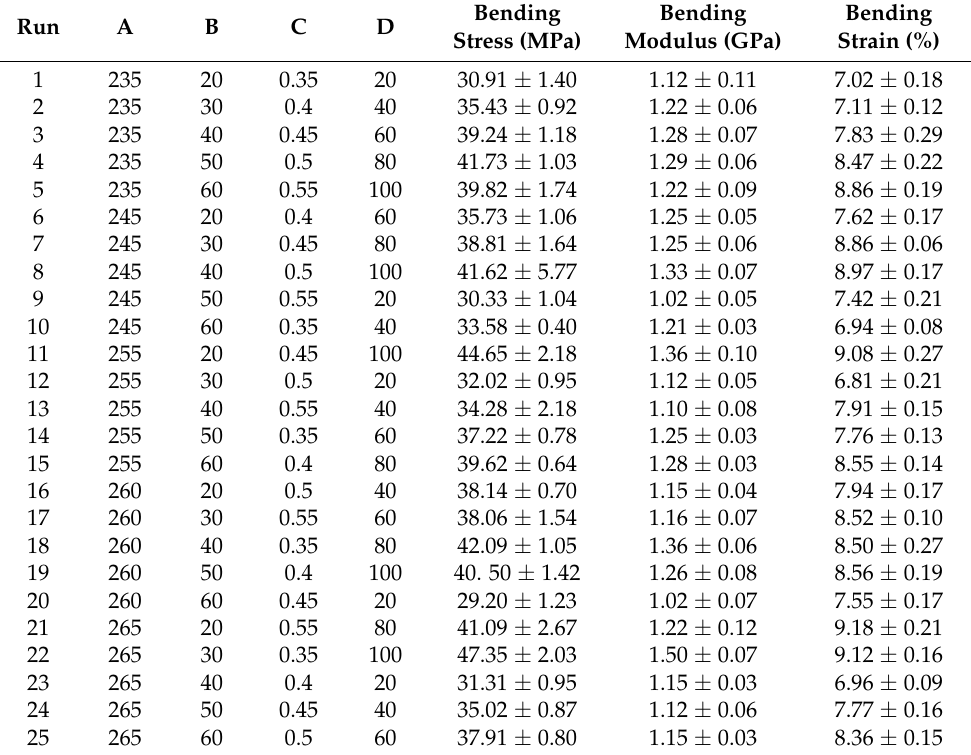
Table 6. Bending experimental results detailed obtained using Taguchi L16 (4 5 ) for